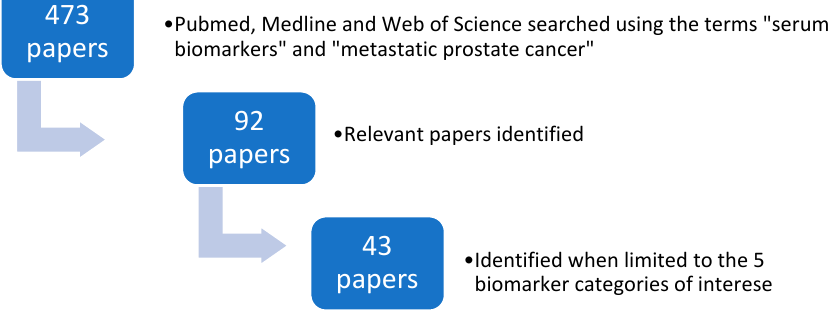
Figure 1. The search strategy used to identify relevant papers.